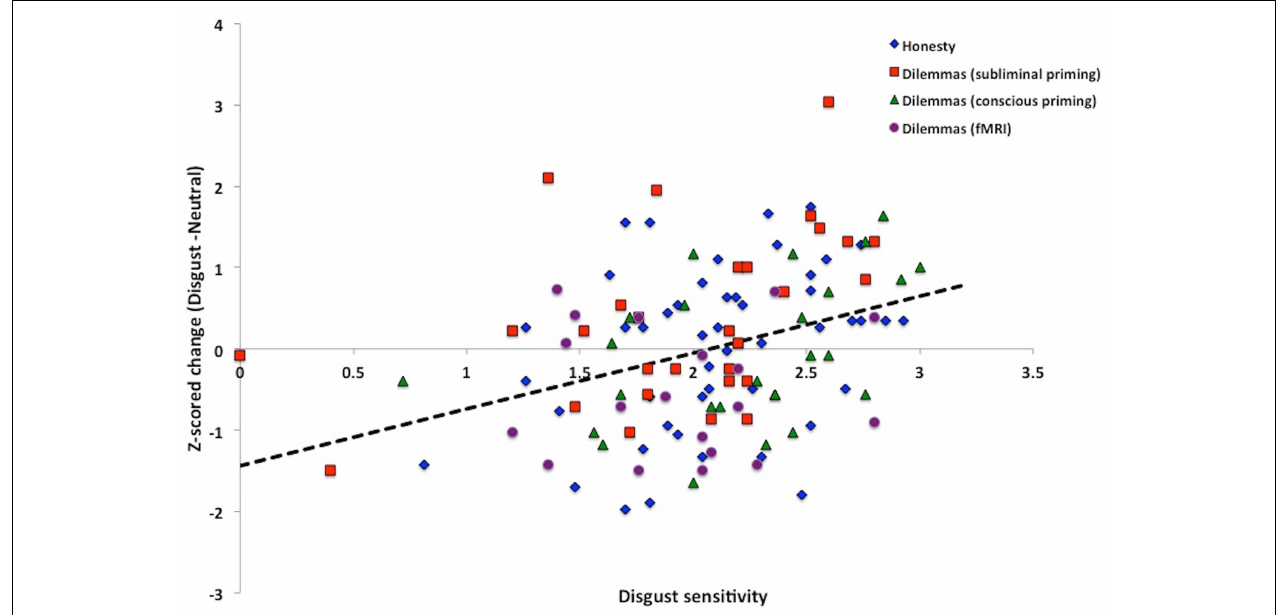
FIGURE 6 | Common bidirectional function. Data from four independent experimental samples ( N = 125 ), testing the effects of disgust presentation on honesty and judgment of moral dilemmas. Combined, these data obeyed the same bidirectional function, without significant main effect or interaction with task